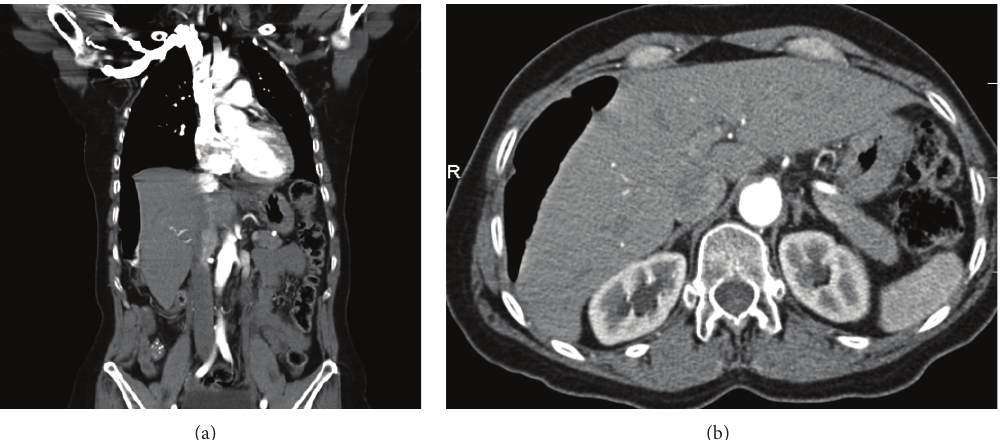
Figure 1: (a) Coronal CT view. (b) Axial CT view. Both demonstrate a loop of colon interpositioned between the liver and right hemidi-